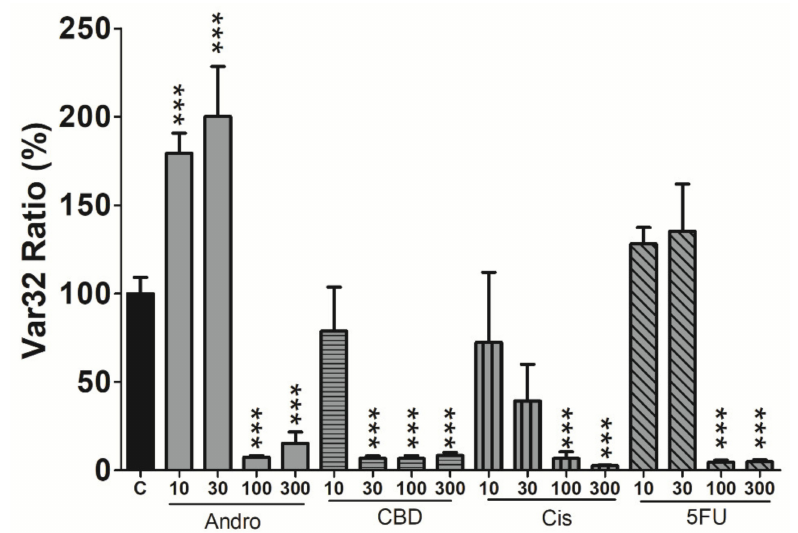
Figure 4. Var32 analysis of SCC-25 cell micromotion 24 h after exposure to di ff erent concentrations of each compound. Values shown are mean ± standard error (n = 4 for each concentration). * p < 0.05, ** p < 0.01, *** p < 0.001. Each value is expressed as a percentage of